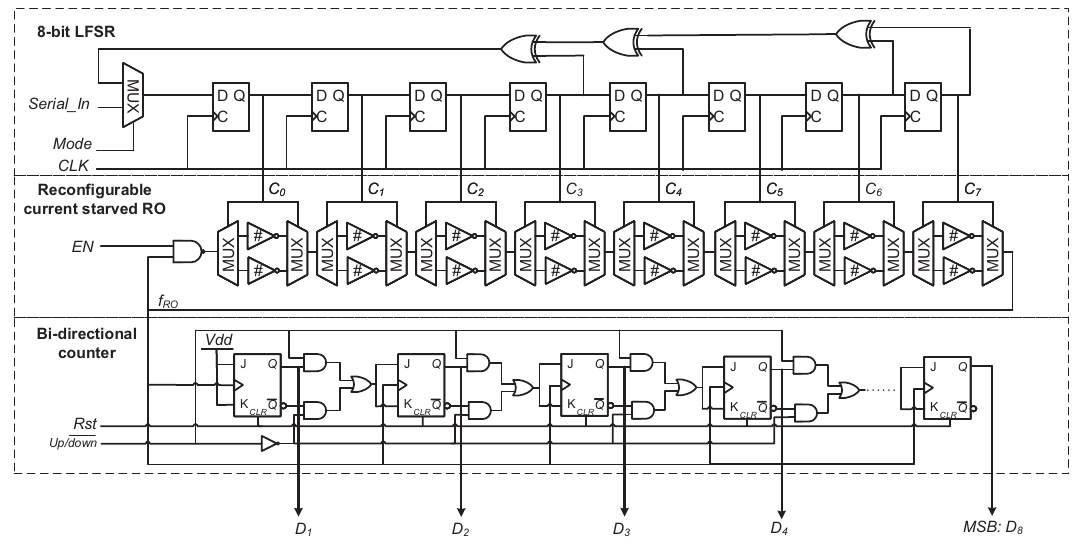
Figure 1. Architecture of the proposed ring oscillator (RO) PUF.